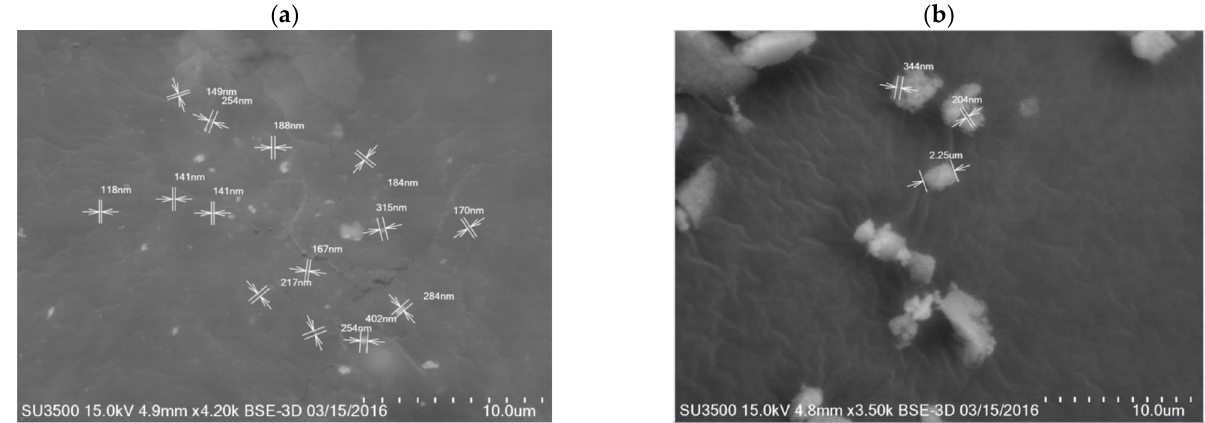
Figure 2. SEM images of Fe 3 O 4 magnetic nanoparticles: ( a ) aggregates and ( b ) single nanoparticles.